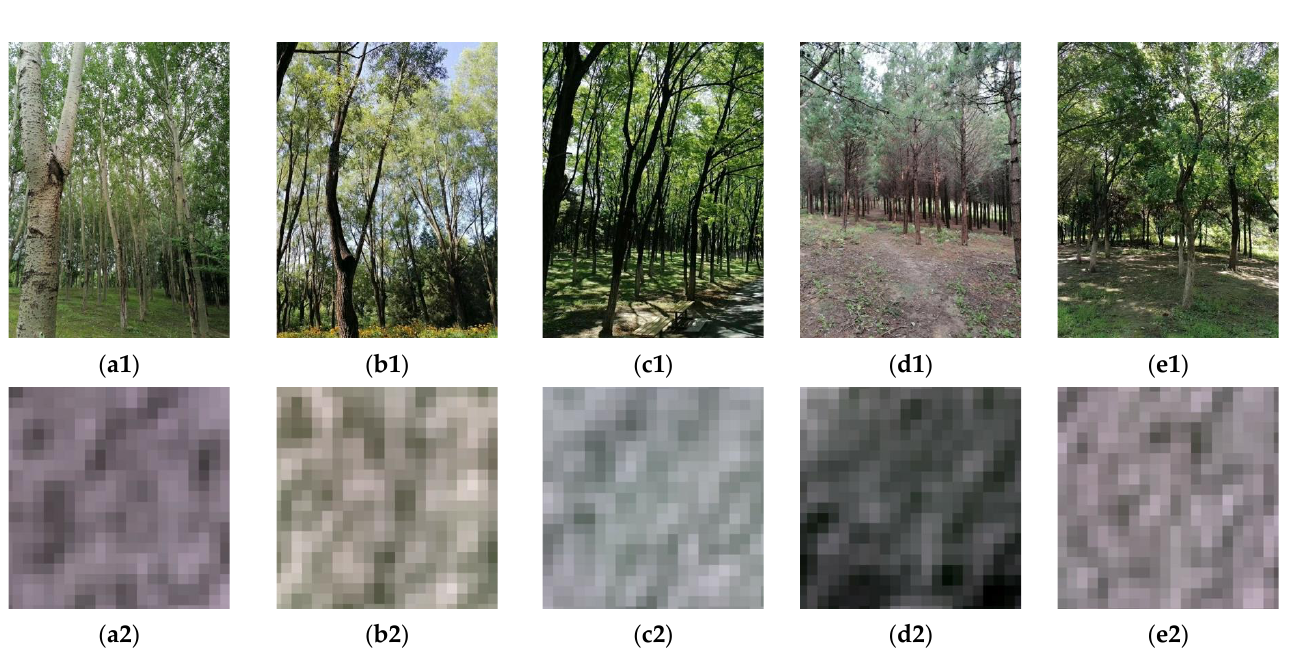
Figure 2. Field sampling photos and high-resolution fusion image photos. Where a1 and a2 are populus, b1 and b2 are willow, c1 and c2 are sophora, d1 and d2 are pine, e1 and e2 are ash. They are the main tree species in each class.